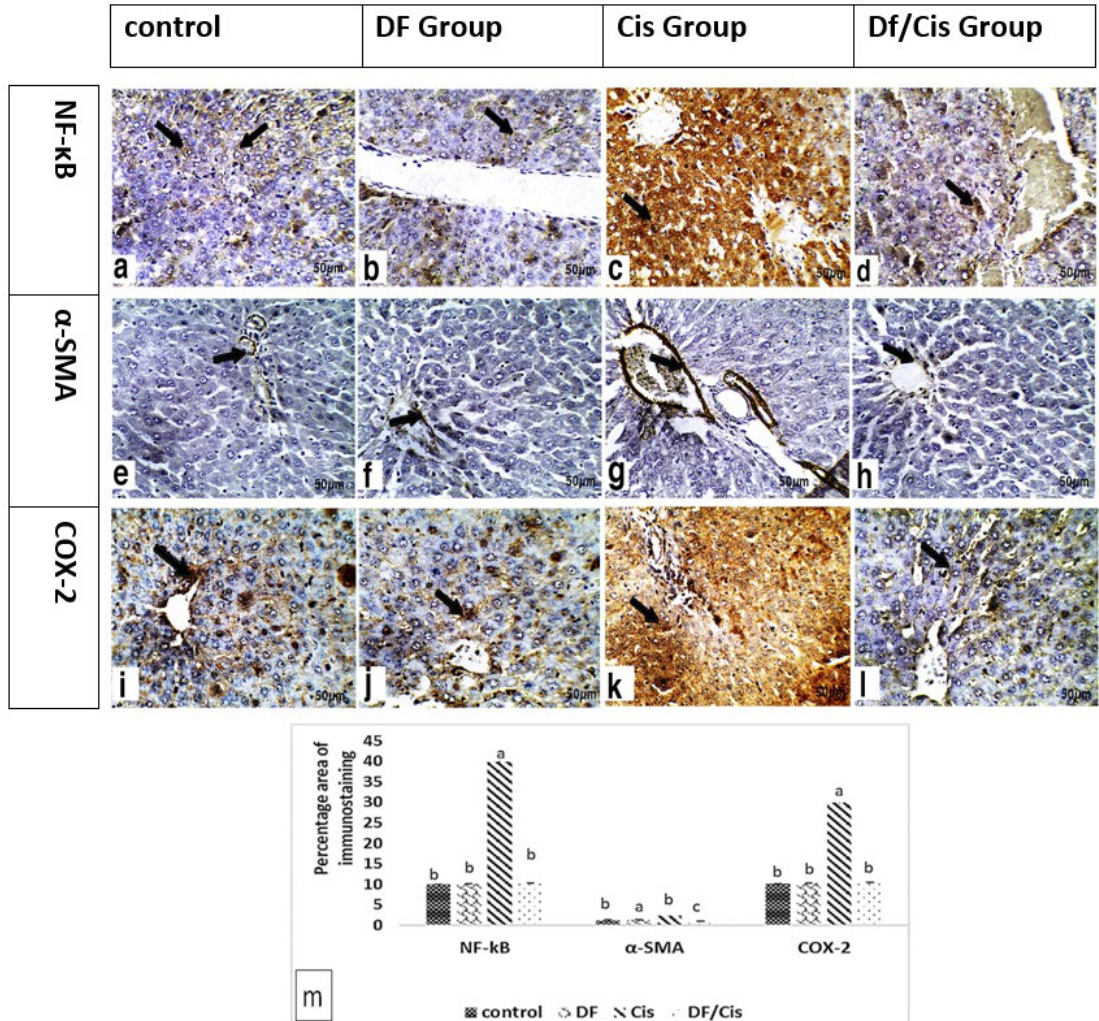
with MDFE revealed mild expression of COX-2 and NF- κ B in the cytoplasm of hepatocytes and mild expression of α -SMA in the hepatic portal area compared with the Cis group.